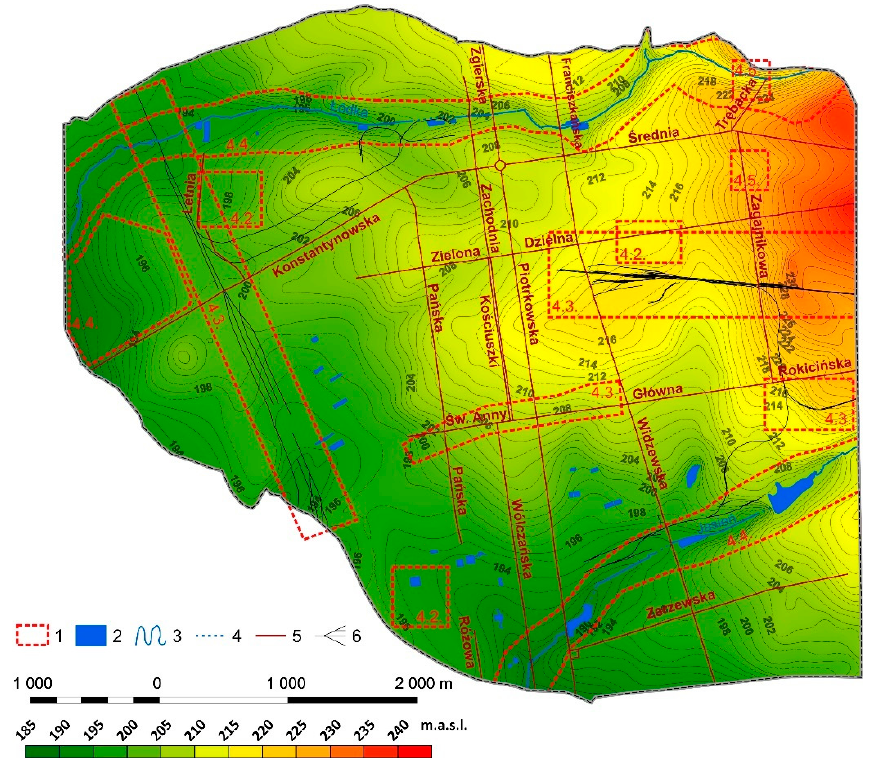
Figure 6. The relief of a fragment of Ł ód ź based on Jasi ń ski’s map (1917). 1—areas of detailed anal- ysis, 2—waters, 3—surface watercourses, 4—underground watercourses, 5—main streets, 6—railway tracks (situation in 1917). Source: Own study.